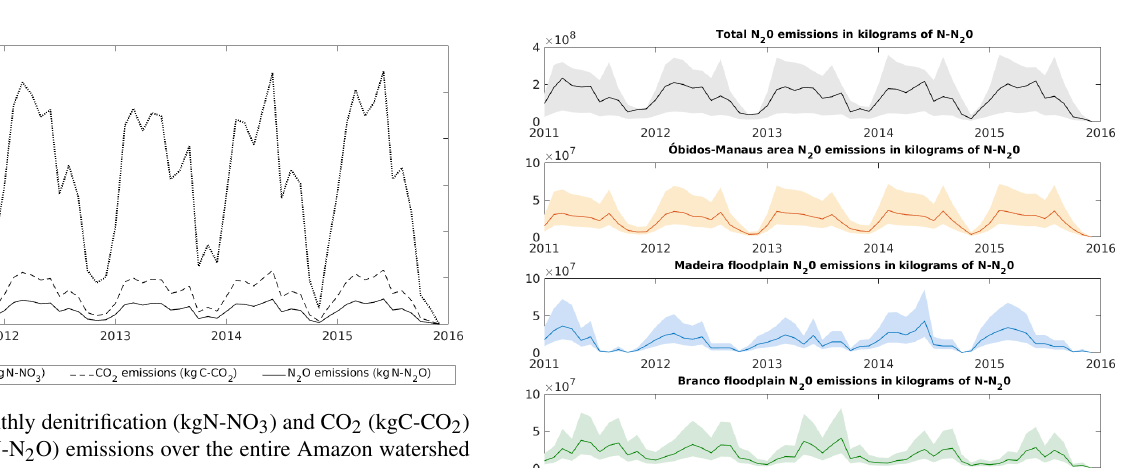
Figure 4. Spatial representation of N 2 O emissions (kgN-N 2 Okm − 2 ), denitrification (molNO − summed over the year 2013. The locations of the main floodplains (hot spots) are outlined in the denitrification map.